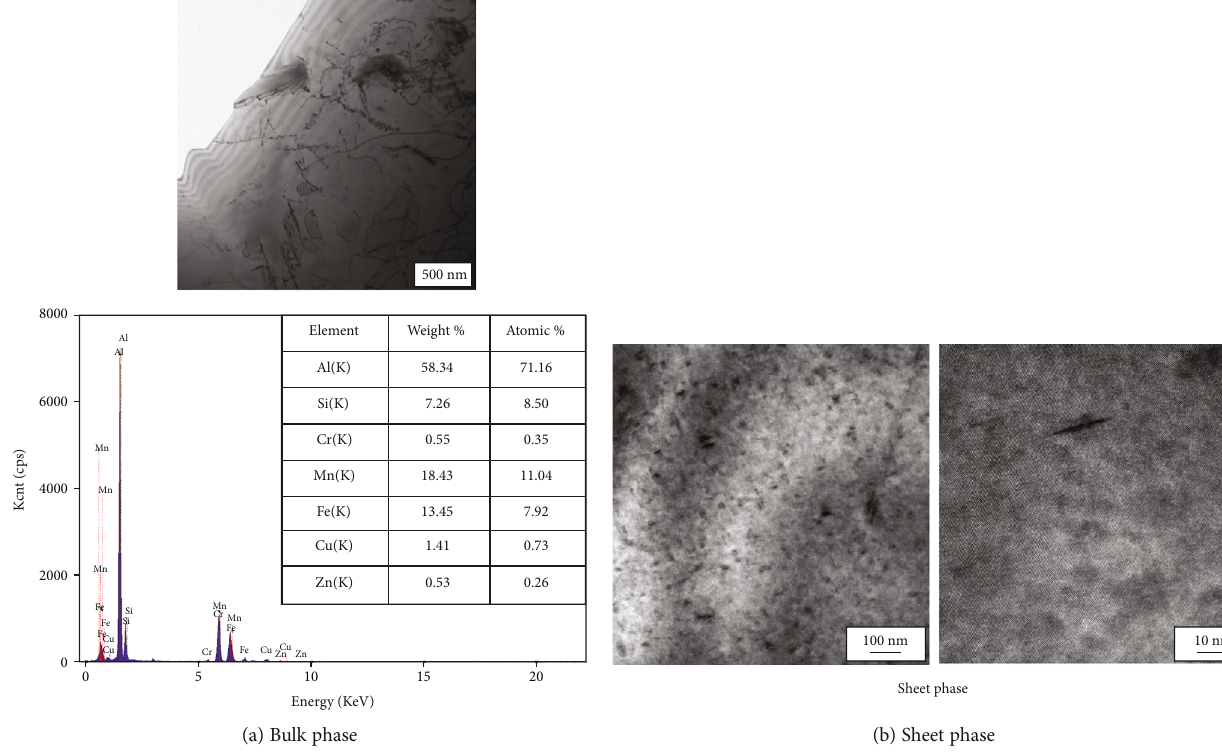
Figure 6: TEM photos of the 3A21 cladding layer and EDS